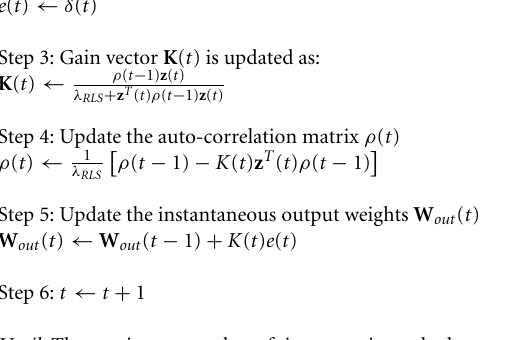
Algorithm 1: Online RLS algorithm for learning reservoir to output neuron